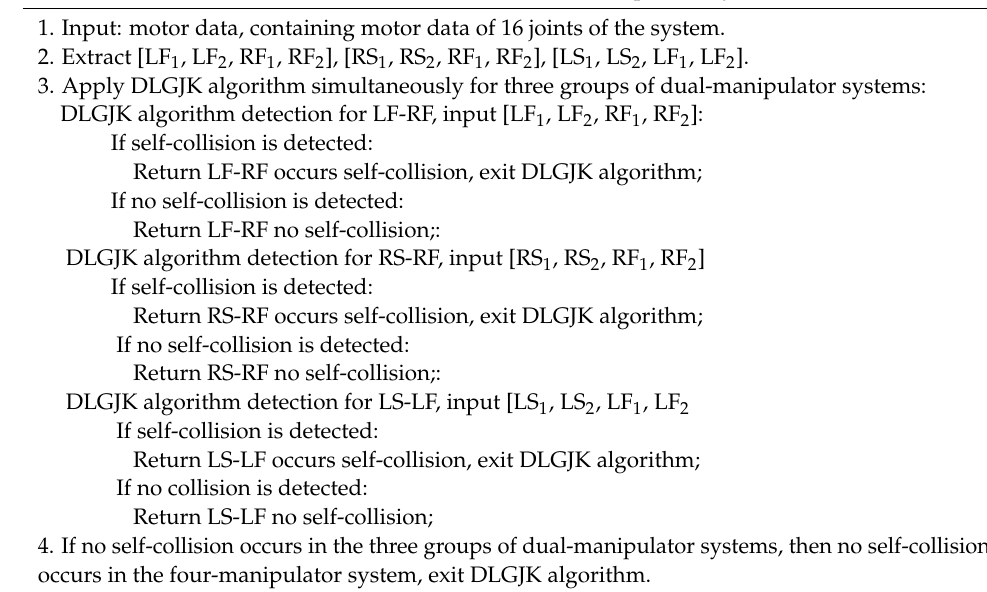
Algorithm 2 DLGJK self-collision detection of the four-manipulator